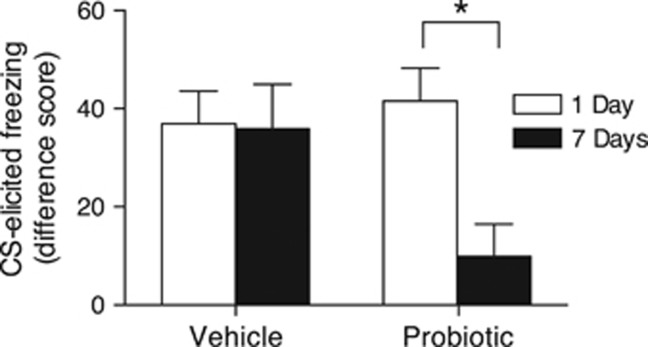
Mean (±s.e.m.) CS-elicited freezing at the retention test for vehicle- and probiotic-exposed maternally separated (MS) infant rats. Vehicle-exposed MS rats exhibited excellent retention at both 1 day (n=14) and 7 days (n=13). Probiotic-exposed MS rats exhibited good retention at the 1-day interval (n=13), but age-appropriate forgetting (that is, infantile amnesia) after 7 days (n=10). *P<0.05. CS, conditioned stimulus.